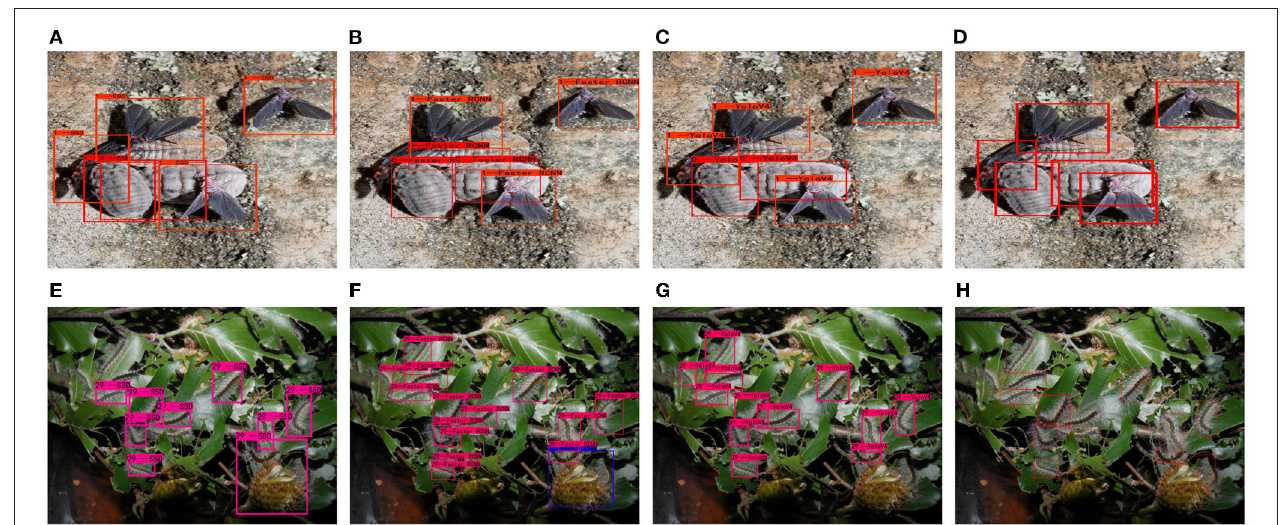
FIGURE 4 | Sample detection results on adults and larvae. From left to right are (A,E) SSD, (B,F) Faster RCNN, (C,G) YOLOV4, and (D,H) Deformable DETR.